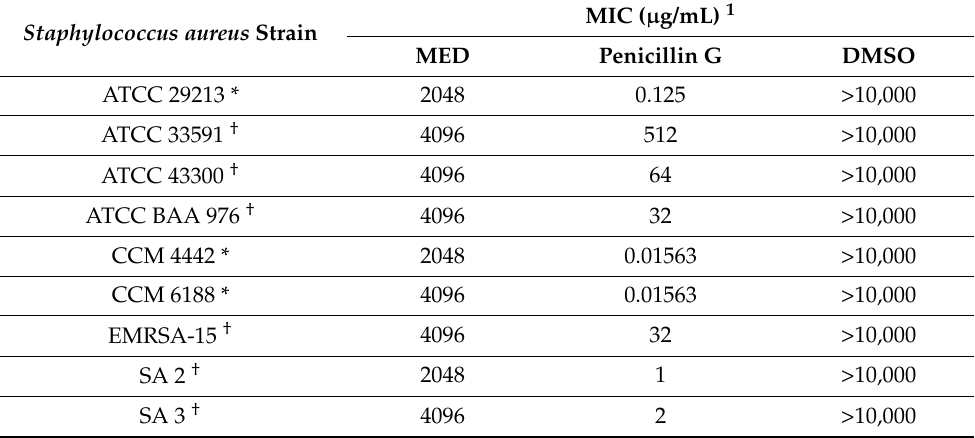
Table 3. Antibacterial effect of the methanolic extract of doenjang (MED), penicillin G, and dimethyl sulfoxide (DMSO) on Staphylococcus aureus strains evaluated by the microdilution broth method as minimum inhibitory concentrations